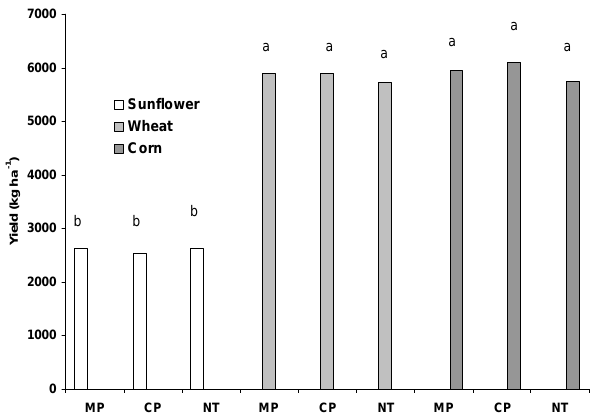
Figure 6. A total of 10 years of average grain yield for sunflower, corn and wheat under moldboard-plow (MP), chisel-plow (CP) and no-till (NT) management. Different letters indicate significant dif- ferences ( p